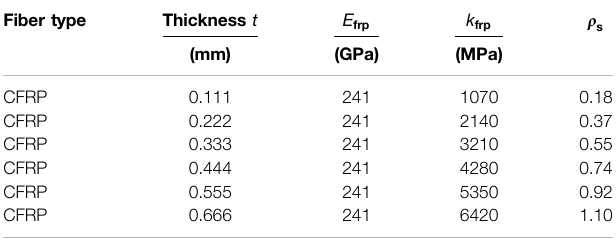
TABLE 1 | Calculated con fi ning stiffness for different thicknesses of con fi ning jacket. Fiber type